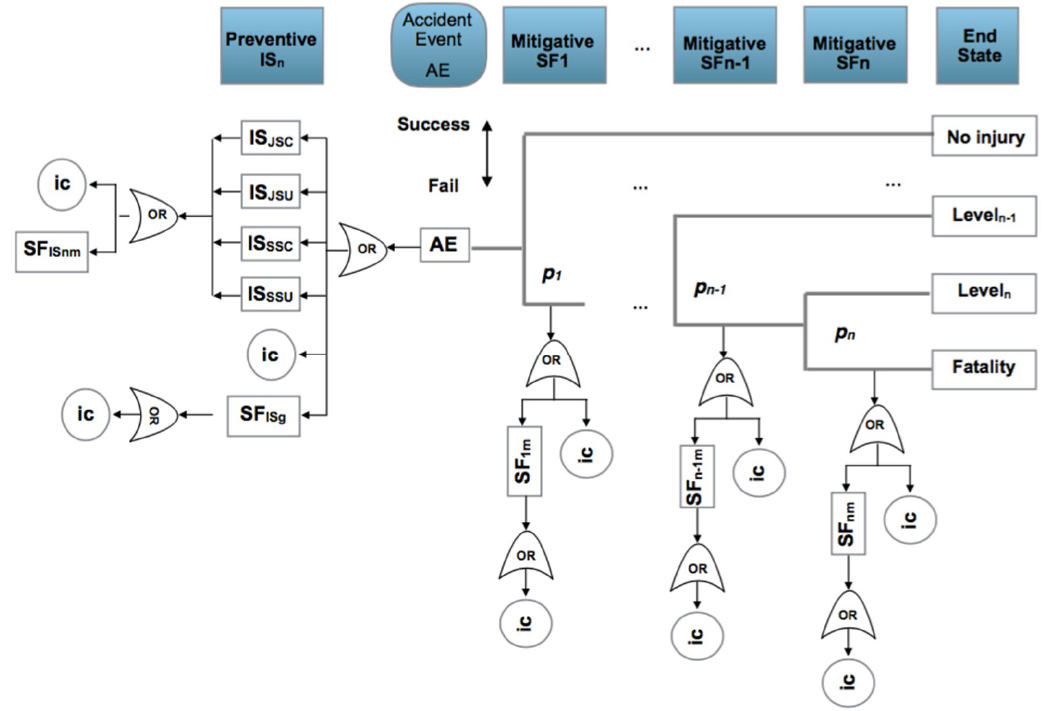
Figure 10. General bow-tie for occupational accidents. Safety barriers: IS n : preventive barrier (n) based on job self control (JSC); job supervision (JSU); safety self control (SSC) and safety supervision (SSU). SF ISg general sub-function working parallel to the human actions; SFn: mitigative barrier (n); SF nm : mitigative or reactive barrier (n) sub-function (m); ic: initiation causes (ba, ha, pot); p ,s,f : probability of success or fail in the mitigative or reactive safety barrier.